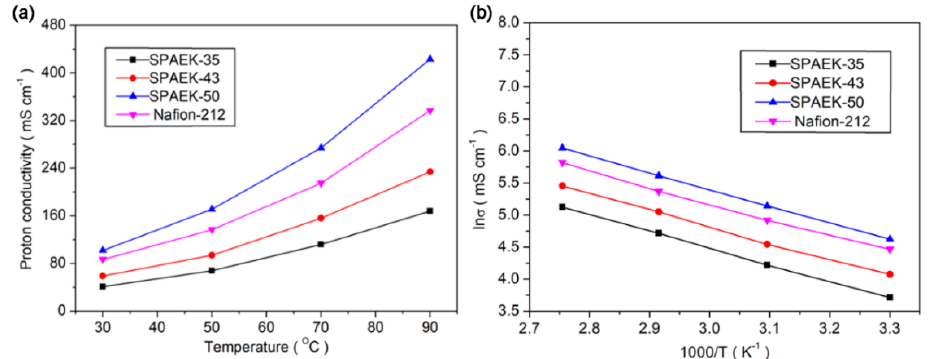
Figure 7. Proton conductivity of SPAEKs and Nafion N212 as a function of temperature.